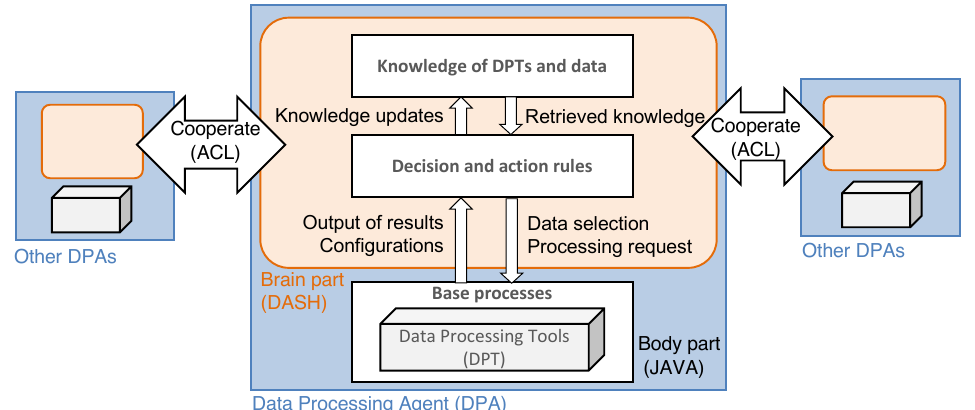
Figure 3. Conceptual diagram of a DPA. The blue part indicates the entire body of the DPA; the orange part indicates the brain component, which consists of knowledge and the decision rules; and the white part corresponds to the original